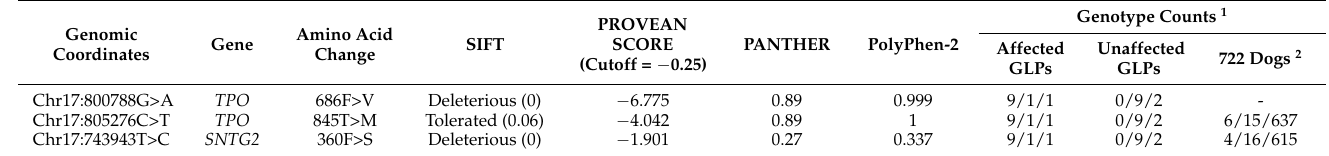
Table 3. Genotype counts of candidate SNPs.